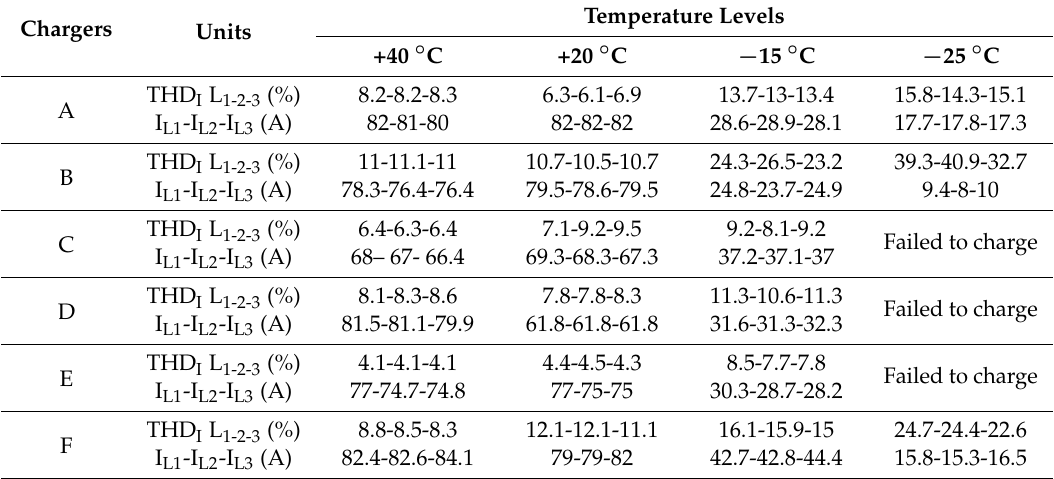
Table 3. Current total harmonic distortion at nominal current per charger, in different